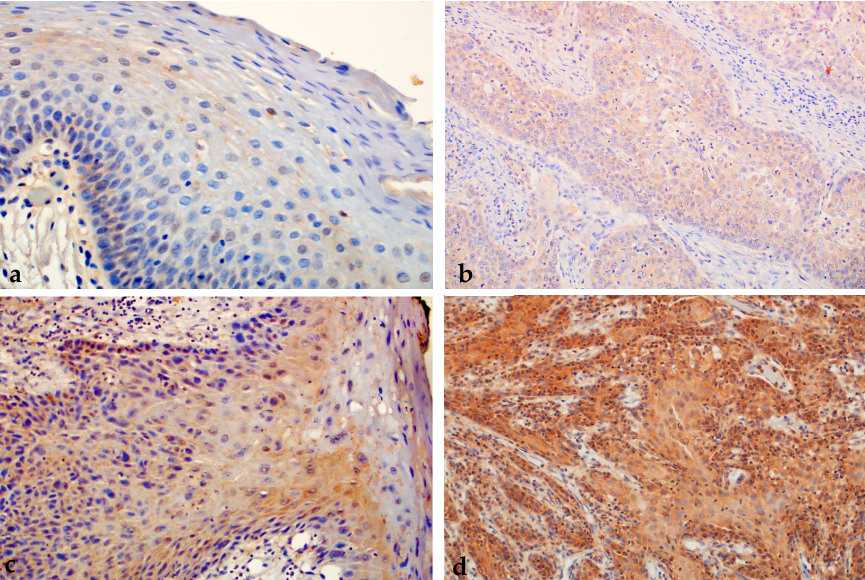
Figure 8. Moderate immunohistochemical expression of ABCG2 (++) in untransformed oral leu- koplakia. Magni fi cation 400× ( a ). Moderate immunohistochemical expression of ABCG2 (++) in OSCC. Magni fi cation 200× ( b ). Strong immunohistochemical expression of ABCG2 (+++) in malig- nant transformed oral erythroplakia with severe epithelial dysplasia. Magni fi cation 200× ( c ). Strong immunohistochemical expression of ABCG2 (+++) in OSCC. Magni fi cation 200× ( d ).